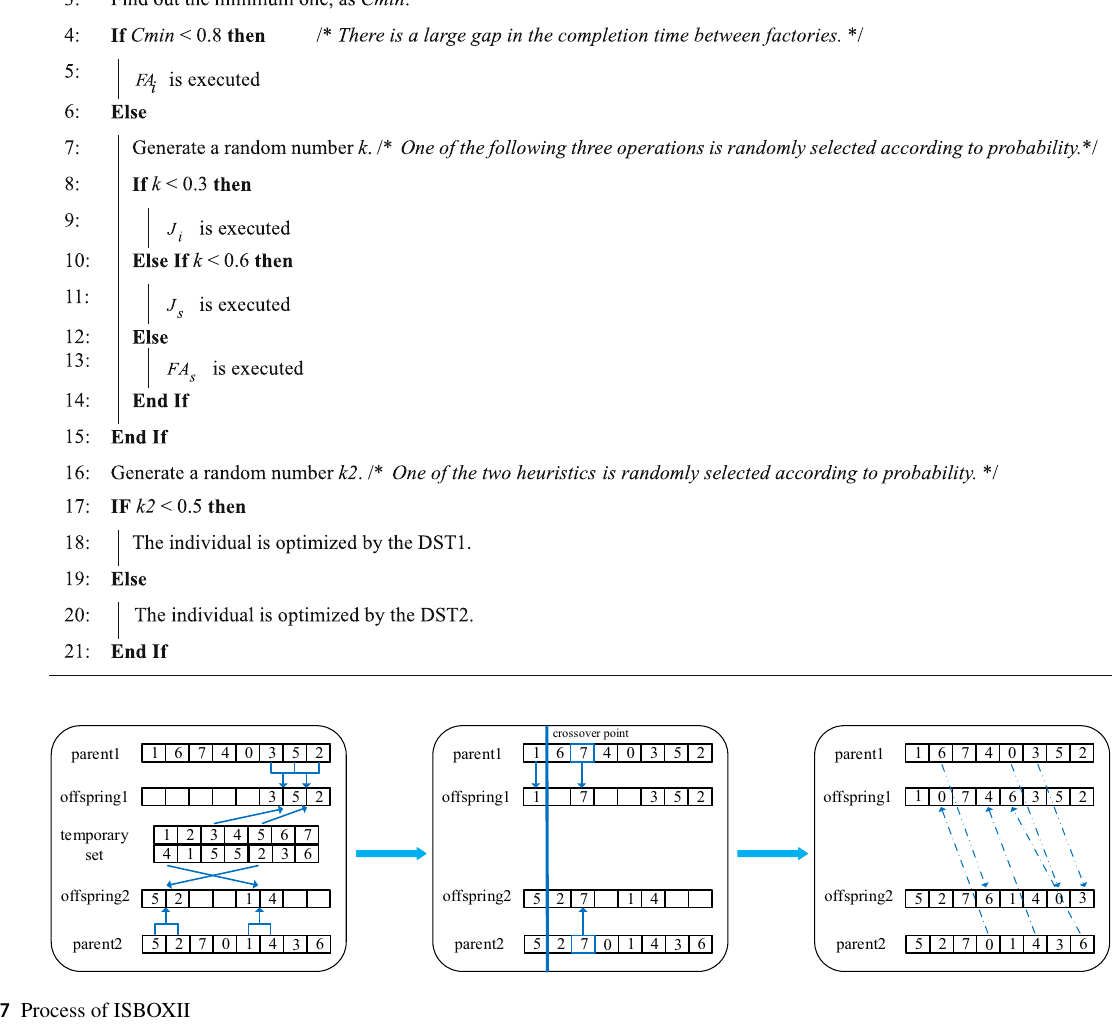
Fig. 7 Process of